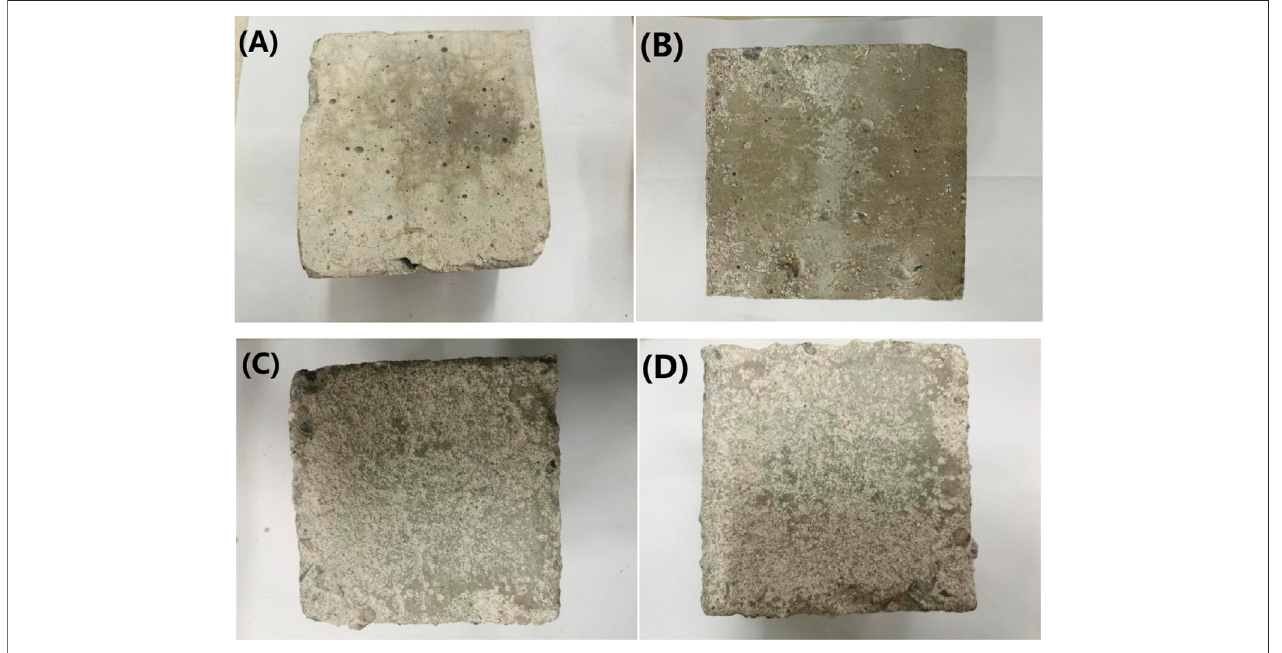
FIGURE 5 | Macro-morphology characteristics of the specimen when it is corroded by corrosive ions: (A) MK0; (B) MK5; (C) MK10; (D) MK15.